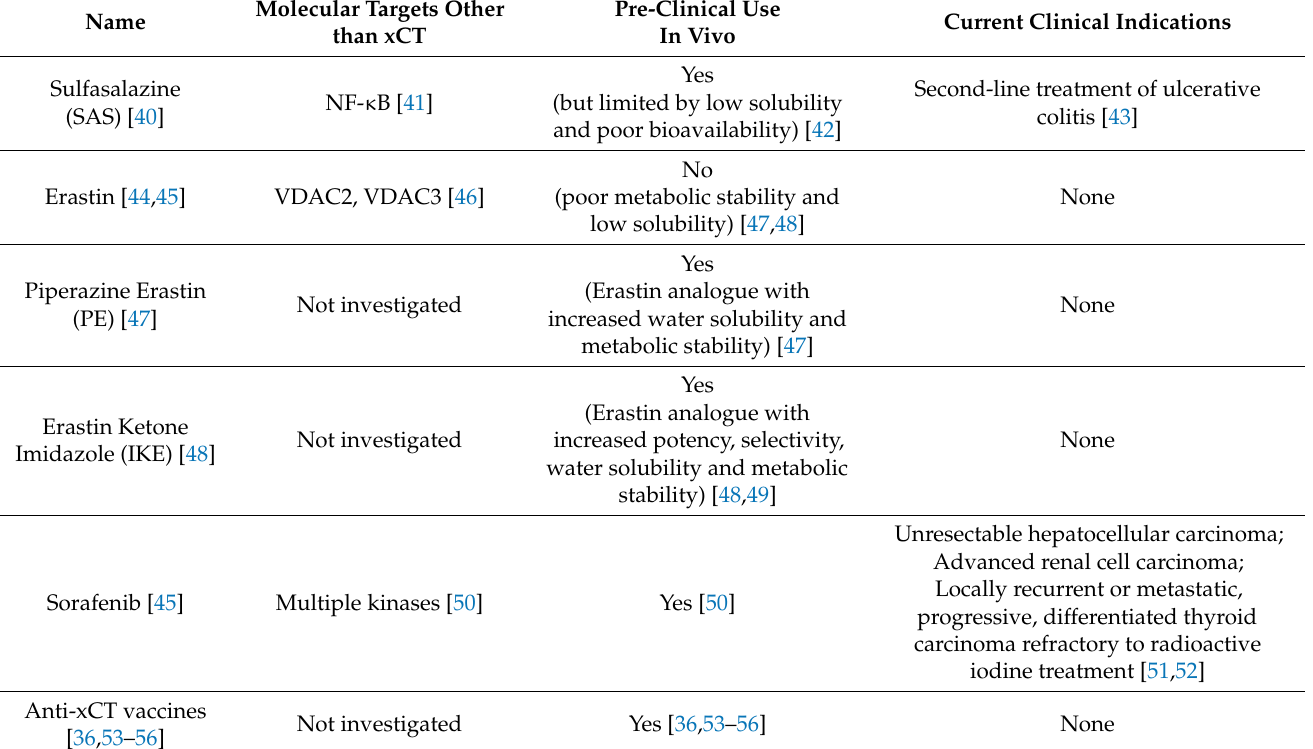
Table 1. A list of xCT